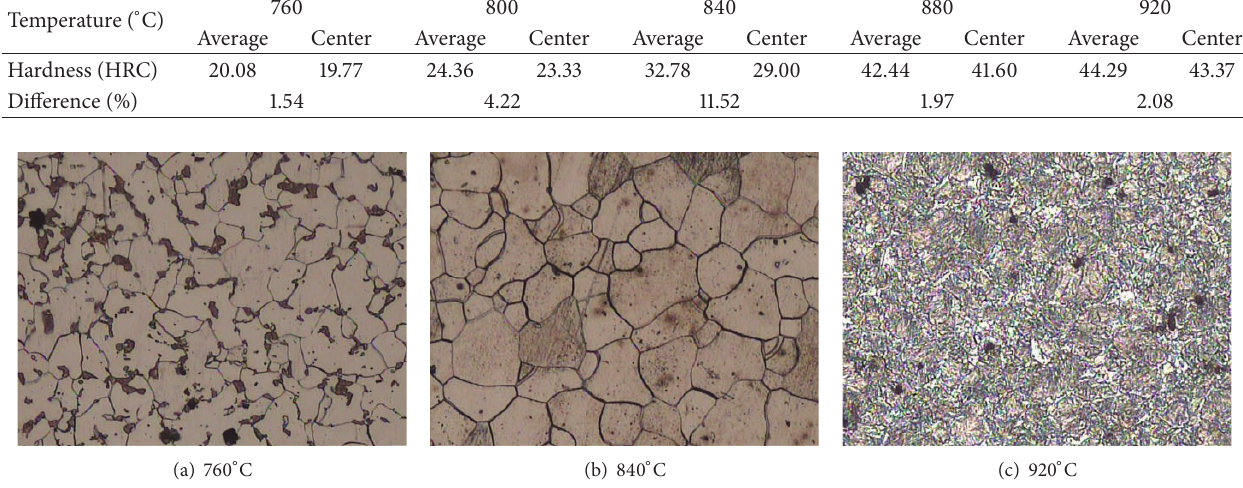
Figure 5: Three different metallographic structures with different temperatures after water quenching.